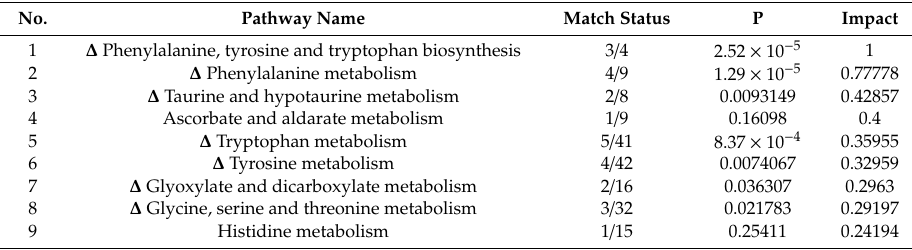
Table 2. Metabolyst Approach Analysis Results Based on